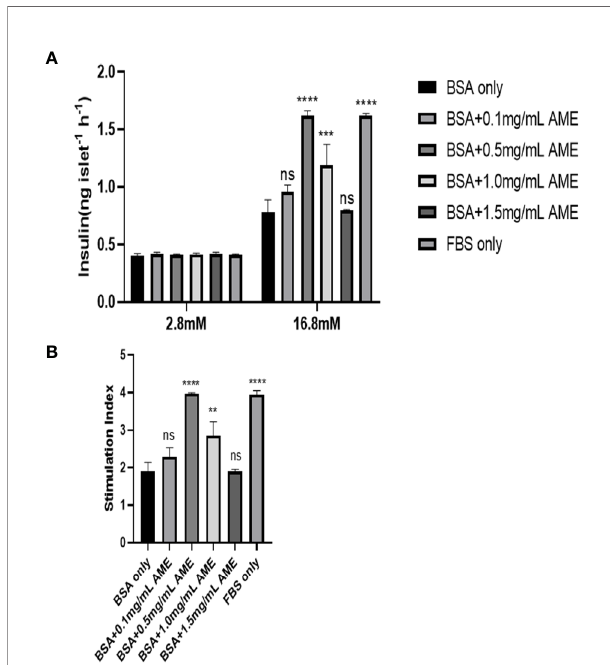
FIGURE 3 | Glucose-stimulated insulin release assay and stimulation index analysis (A) . After 48 h cultivation, 10 islets were picked from each group and assayed for GSIS. The improvement of insulin secretory function by AME peaked at the concentration of 0.5 mg/ml (***p < 0.001, ****p < 0.0001, and ns vs. BSA only group, Two-way ANOVA) (B) . The stimulation index was calculated (**p < 0.01, ****p < 0.0001, and ns vs. BSA only group, One-way ANOVA). Results are shown as means ± SD of three independent experiments.